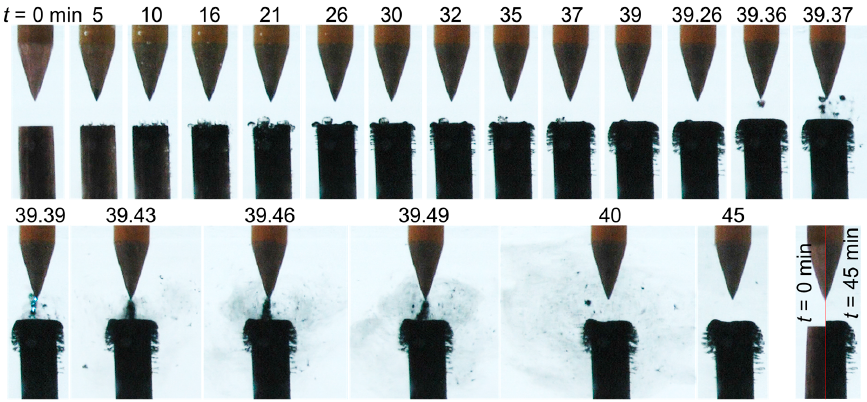
Figure 5. Temporal evolution of the liquid-electrode zone for case 2 ( σ 0 = 8 µS/cm).